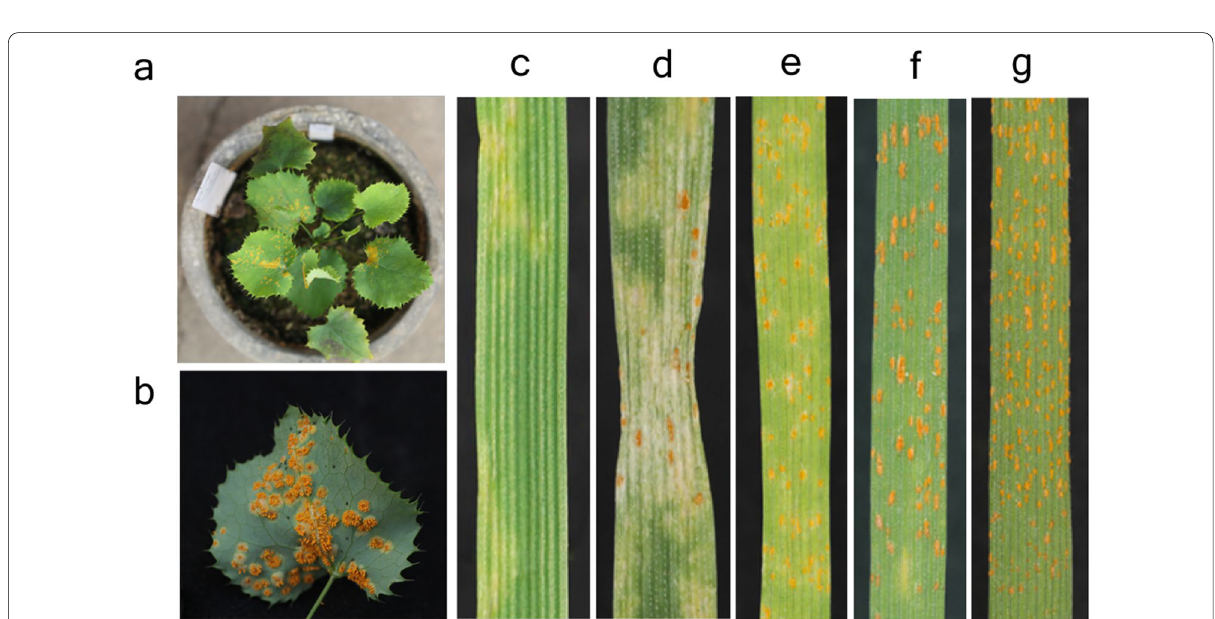
Fig. 5 Wheat Mingxian 169 reaction types after infection with aeciospores from barberry ( B. shensiana ). Grass leaves with telial sori were collected in March, 2014. Teliospore germination was then determined and basidiospores derived from germinated teliospores were used for inoculation of barberry seedlings. Aeciospores produced on barberry were subsequently used for inoculation of Mingxian 169 wheat cultivars and infection types of these Pst isolates were determined on a 0-to-4 scale. a , b Pycnia and aecia produced on barberry leaves after inoculation with basidiospores